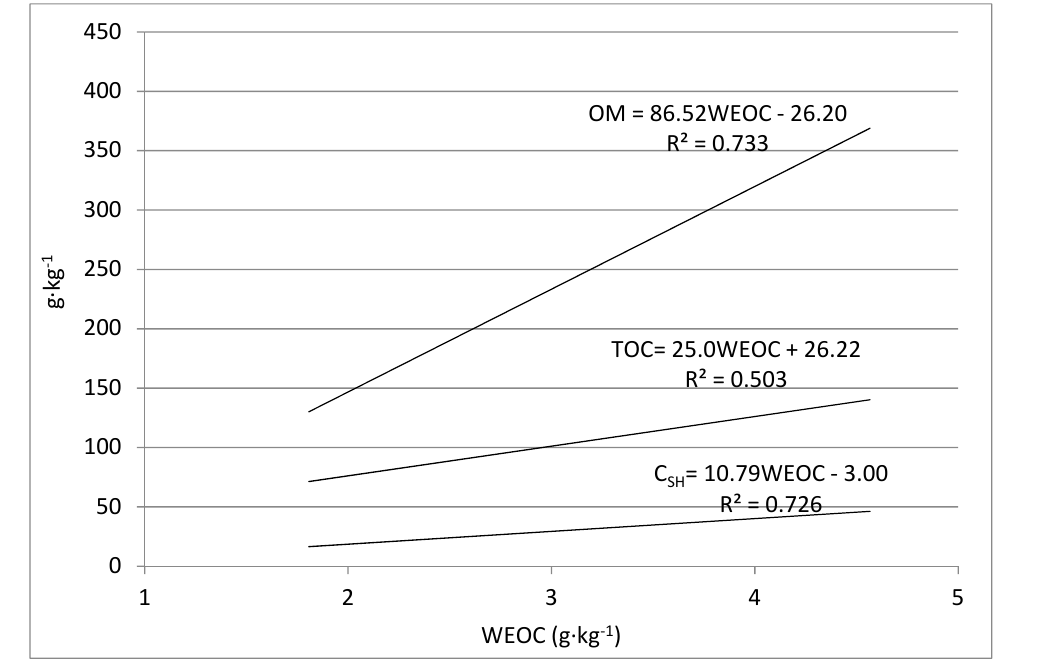
Figure 9. Linear regression for water extractable organic carbon (WEOC) and humic substance (C SH ), total organic carbon (TOC) and organic matter (OM) in composts.